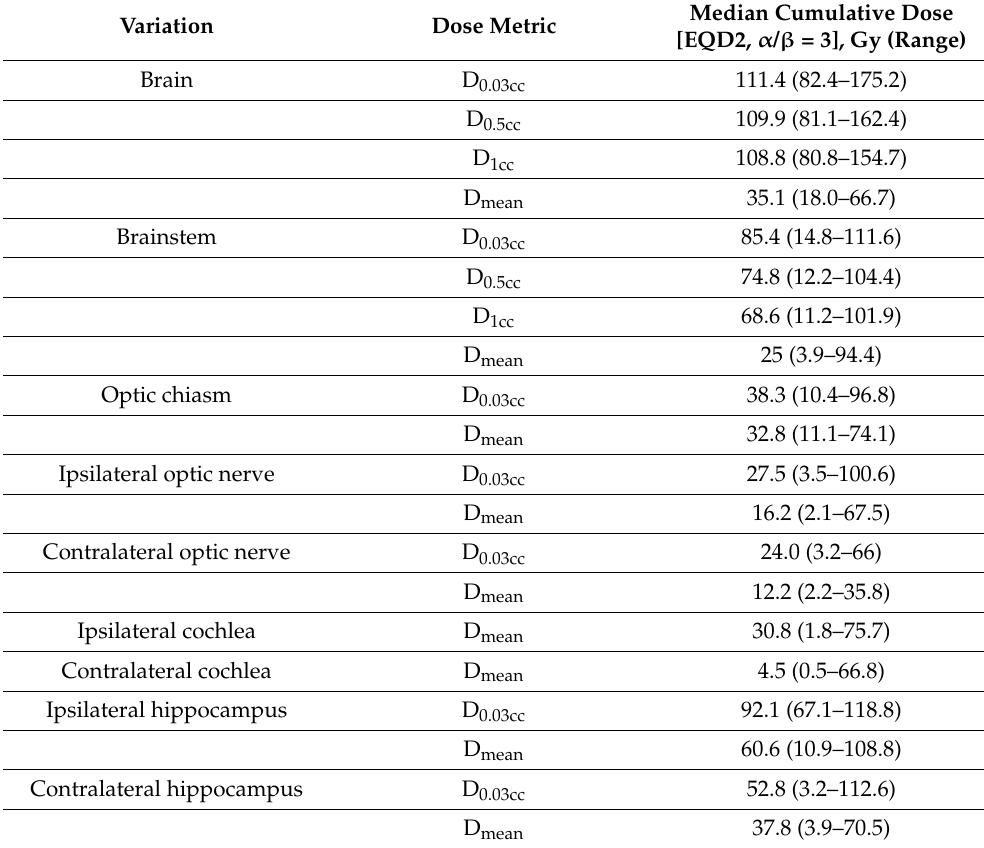
Table 2. Cumulative dose in EQD2 ( α / β = 3) dose parameters for the organs at risk.